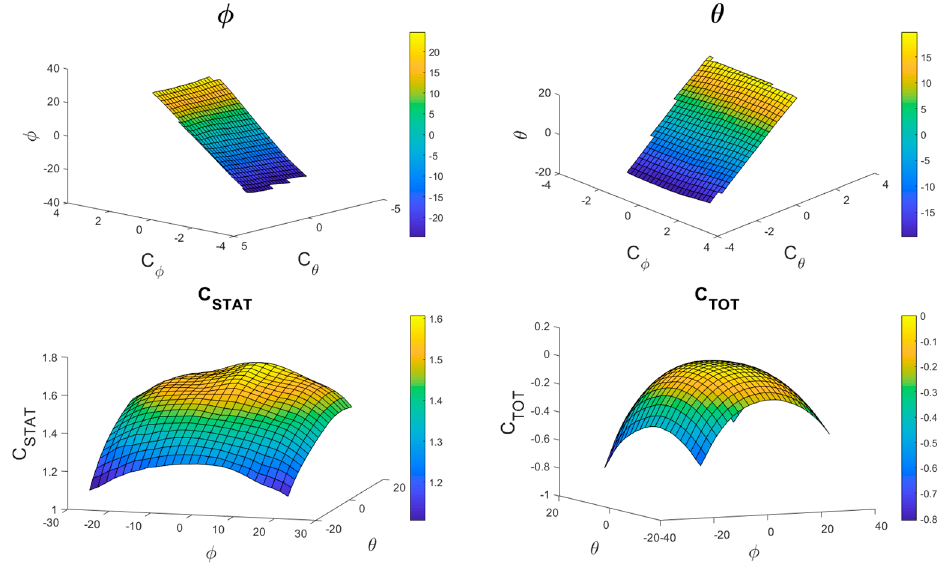
Figure 4. 3D Graphs for first 5-hole probe: 𝜑(cid:3435)𝐶 (cid:3101) , 𝐶 (cid:3087) (cid:3439) ; 𝜃(cid:3435)𝐶 (cid:3101) , 𝐶 (cid:3087) (cid:3439) ; 𝐶 (cid:3046)(cid:3047)(cid:3028)(cid:3047) (cid:4666)𝜑 , 𝜃(cid:4667) ; 𝐶 (cid:3047)(cid:3042)(cid:3047) (cid:4666)𝜑 , 𝜃(cid:4667) [11].